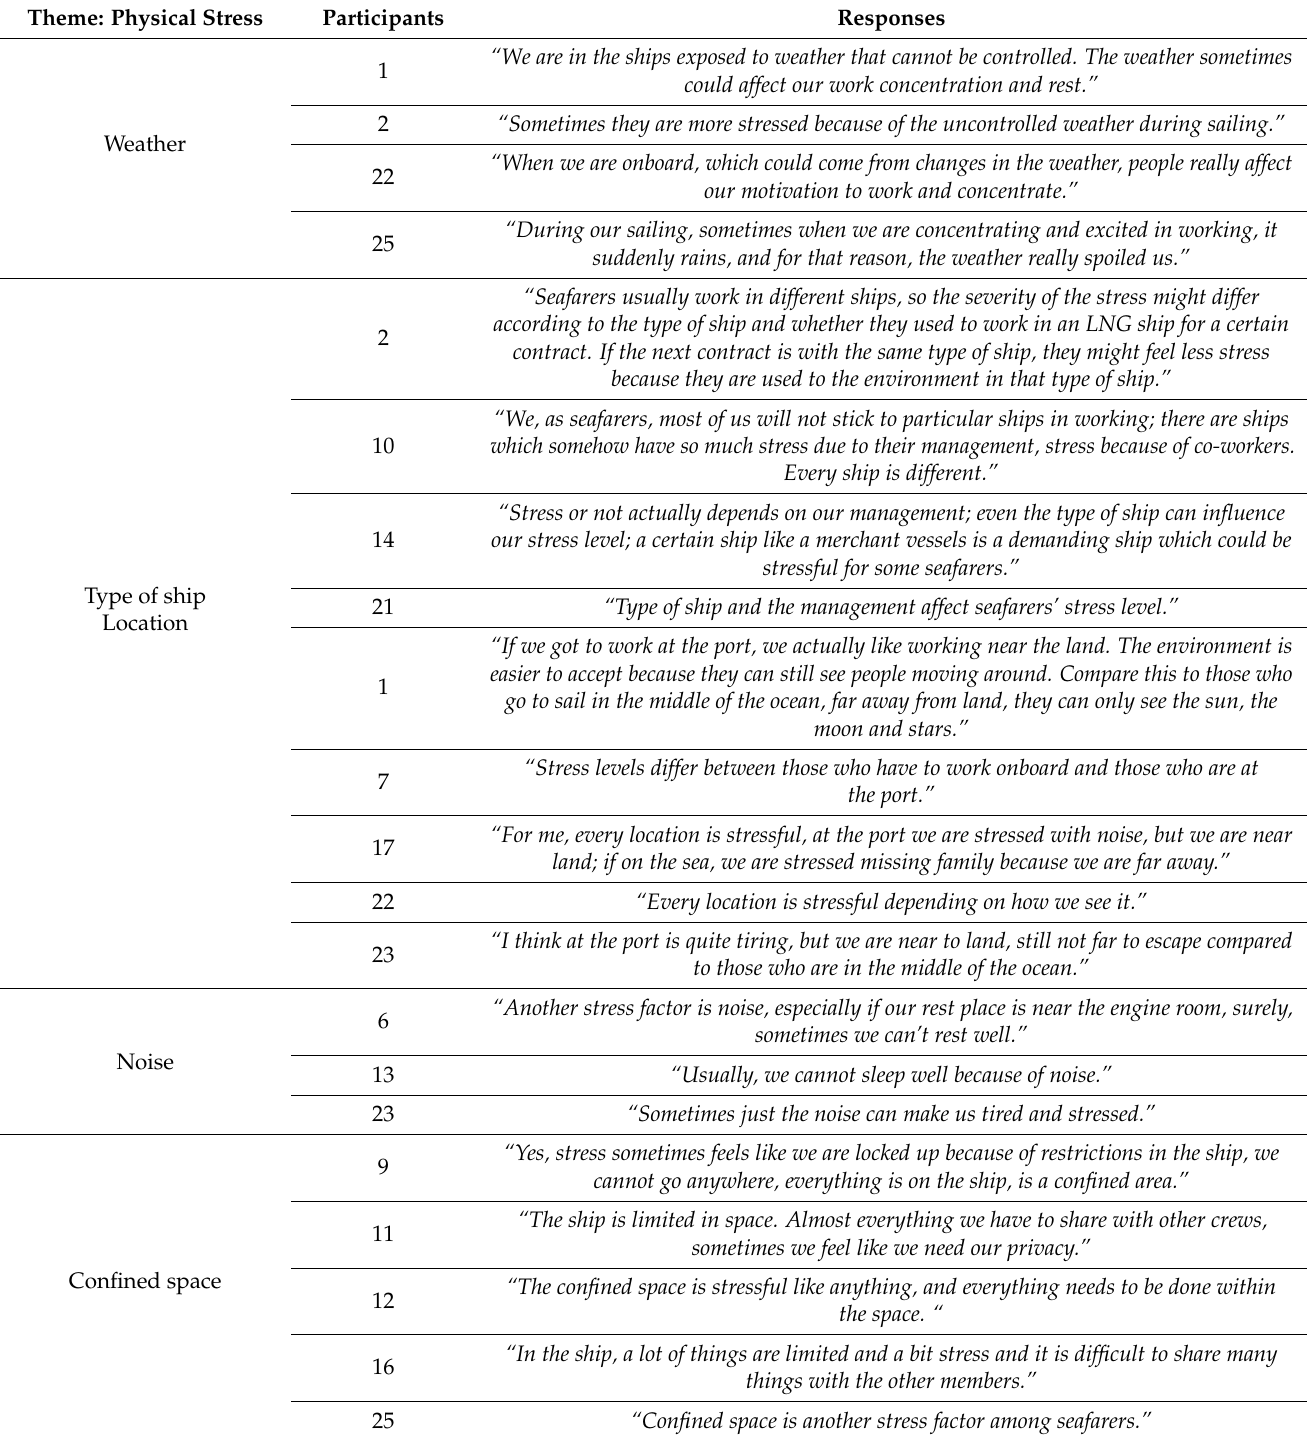
Table 4. Theme of physical